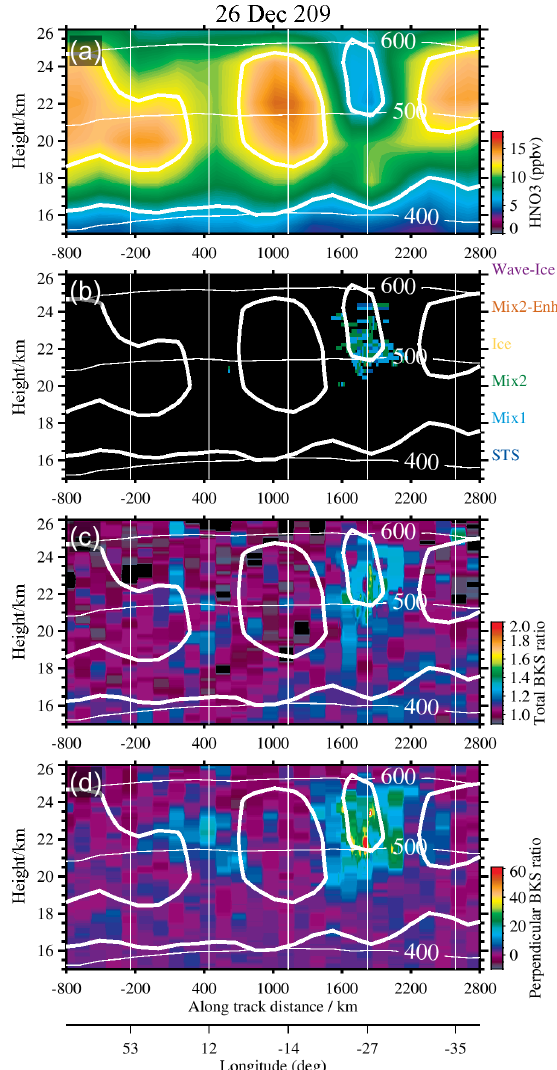
Figure 3. Comparison of along-track data for the partial orbit shown by Hoyle et al. (2013) (note that the x axis is reversed here from their figure). (a) MLS HNO 3 showing sequestration at 12 and − 27 ◦ longitude. (b) CALIOP PSC Mask does not show detection of PSCs at 12 ◦ longitude. (c) Smoothed CALIOP total backscatter ra- tio. (d) Smoothed CALIOP perpendicular backscatter ratio. Solid thick white contours are the MLS HNO 3 isolines for 7 and 12ppbv HNO 3 . Solid thin white vertical lines are the longitude markers shown by Hoyle et al. (2013). The detection of PSCs near 12 ◦ longi- tude is evident in the smoothed CALIOP perpendicular backscatter ratio along with the corresponding HNO 3 sequestration measured by MLS in (a)